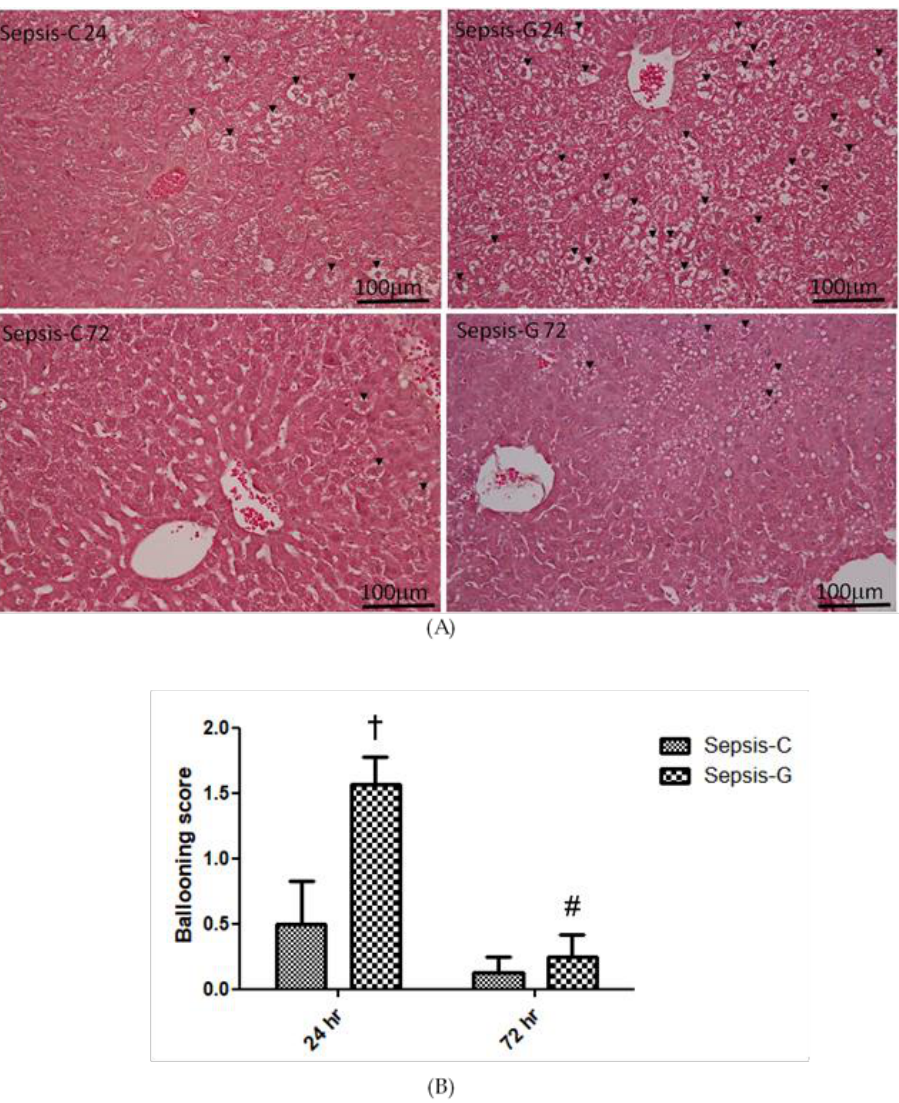
Figure 5. Histopathology of liver tissues. ( A ) Hematoxylin and eosin staining. Representative histological images are shown at 100 × magnification. Cellular ballooning was indicated by arrows. ( B ) hepatocellular ballooning scores of the liver. Sham: control group with a sham operation; Sepsis-C: control group with cecal ligation and puncture (CLP); Sepsis-G: glutamine (GLN) group with a CLP operation. Data are presented as the mean ± standard error of the mean (SEM). † Significantly di ff ers from the Sepsis-C group at 24 h after CLP. # Significantly di ff ers from the Sepsis-G group at 24 h after CLP (p <